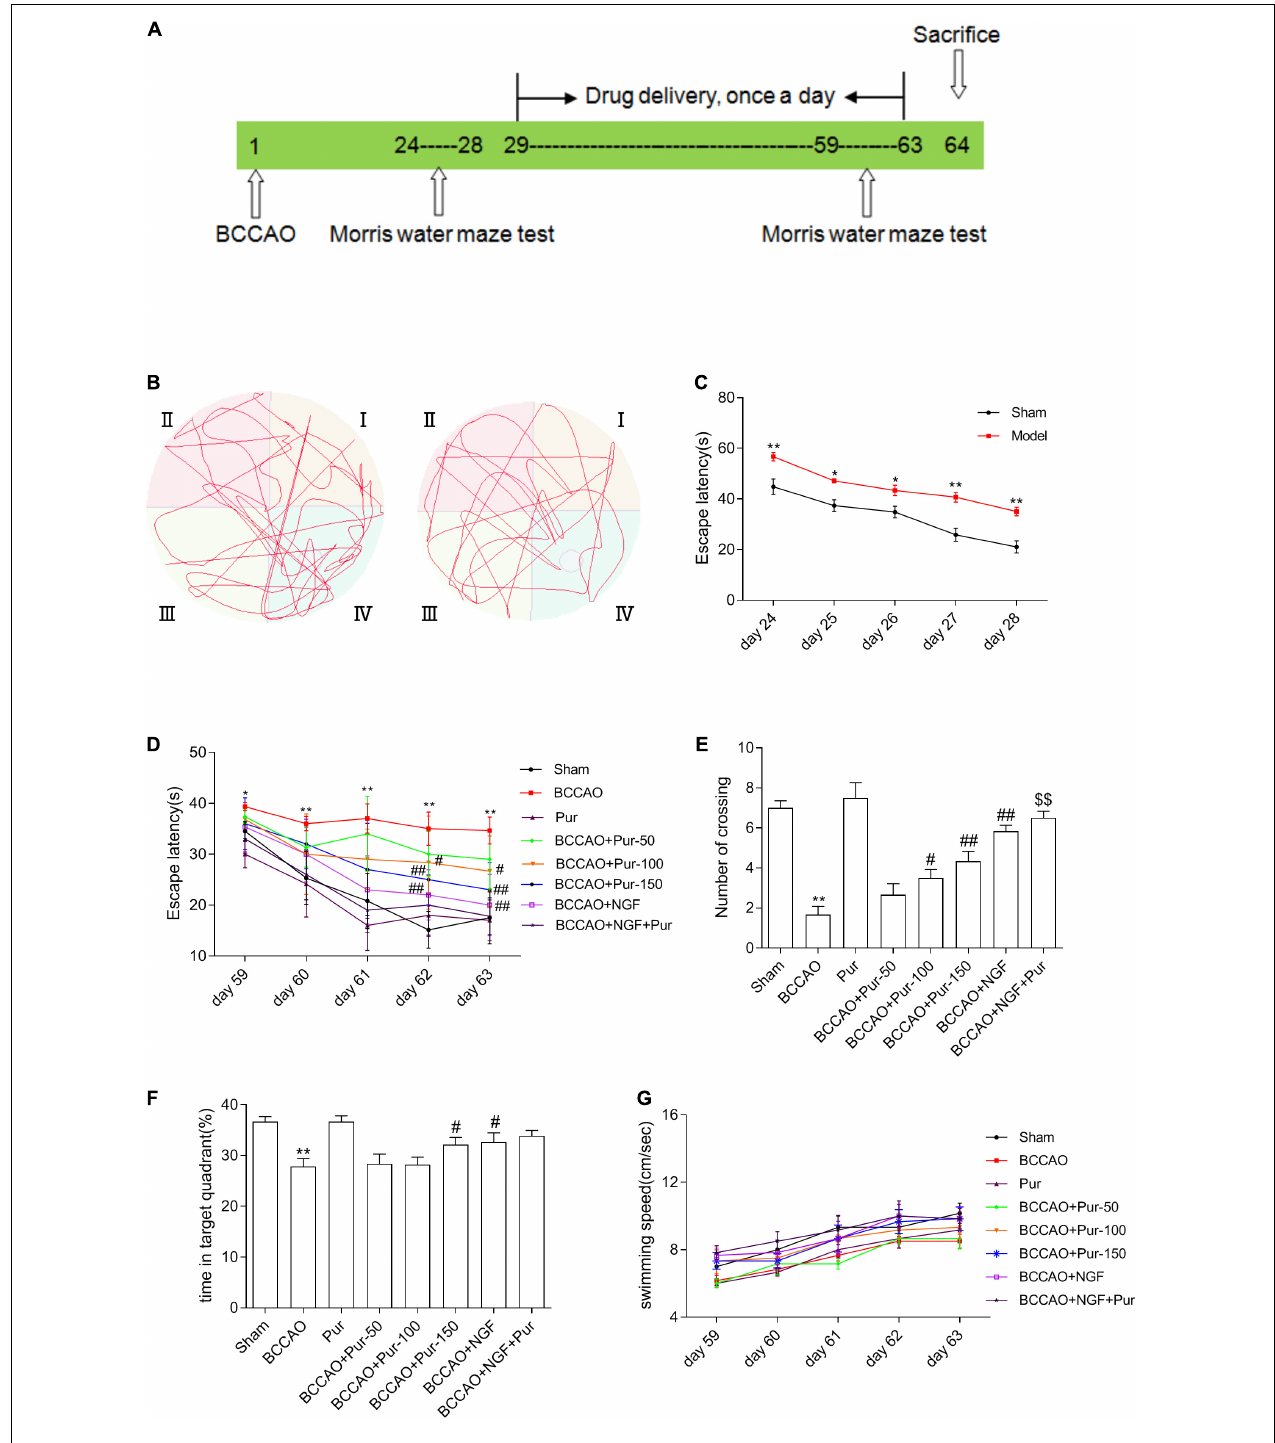
FIGURE 1 | Effects of puerarin (Pur) on occlusion of bilateral common carotid arteries (BCCAO)-induced spatial memory impairment. (A) Timeline of surgery (BCCAO), drug administration and behavioral assays. (B) Results of the Morris water maze (MWM) (days 28 following BCCAO) in the sham and BACCO groups. (C) Escape latency (starting site to the hidden platform) at days 24–28 post-BCCAO). (D) Escape latency at days 59–63, during Pur treatment. (E) Numbers of crossings in the target quadrant within 60 s in the probe trial on day 63. (F) Percentages of time spent in the target quadrant within 60 s in the probe trial (no platform) on day 63. (G) Swimming speed (path length by escape latency) in each group at days 59–63. Values were mean ± SEM ( n = 6). * P < 0.05, ** P < 0.01 vs. Sham; # P < 0.05, ## P < 0.01 vs. BCCAO; $$ P < 0.01 vs. BCCAO + Pur (150 mg/kg/day).